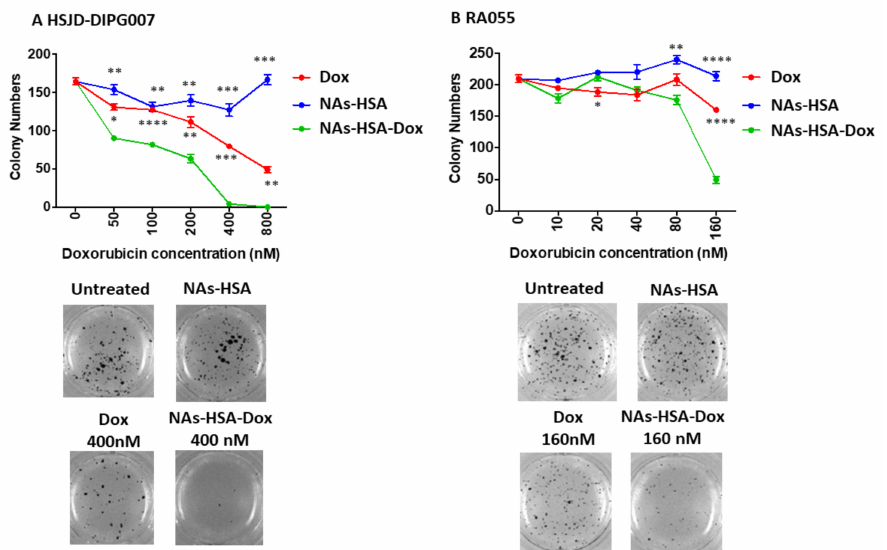
Figure 3. DIPG colony formation is reduced upon treatment with doxorubicin-loaded gold nanoparti- cles; ( A / B ) Soft agar colony assays were performed in two DIPG primary cultures ( A ) HSJD-DIPG007 and ( B ) RA055 DIPG cells with various concentrations of Dox, NAs-HSA-Dox and NAs-HSA. Colonies were stained with MTT after 2–3 weeks and counted. Both cultures display significantly lower colony formation when treated with NAs-HSA-Dox compared to doxorubicin alone. In con- trast, DIPG cells treated with NAs-HSA had no effects on colony formation. * p < 0.05; ** p < 0.01; *** p < 0.001; **** p < 0.0001. The experiment was performed twice N = 4 each time.